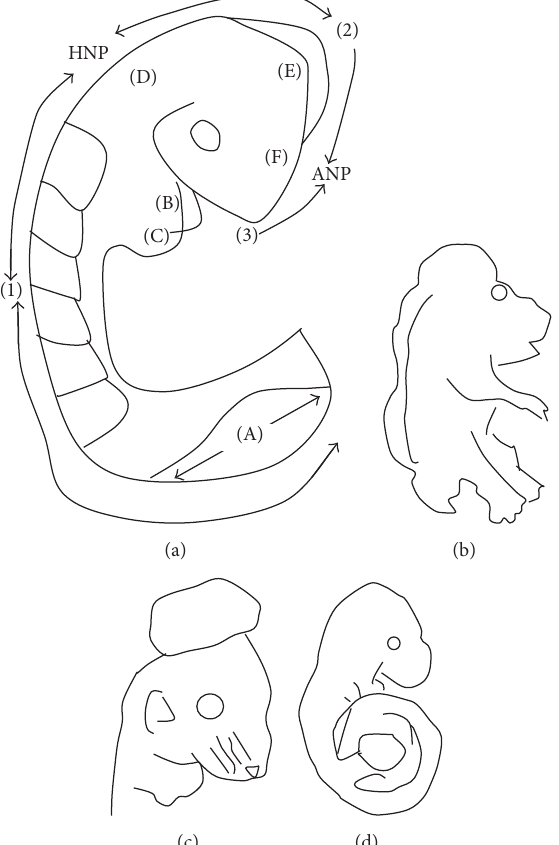
Figure 2: Points of closure in the mouse embryo and phenotypes of failure of closure of the various points along the neuraxis. (a) Schematic figure illustrating the multiple points of closure of the neural tube, directions of closure, and the different locations of neuropores in the developing embryo. (1), site of closure (1) which occurs at the level of somite 3 in the 6-7-somite embryo. Closure (1) is the initiation event of neurulation. Closure then progresses caudally and is completed by closure of the posterior neuropore (PNP) at the 29-30-somite stage of development; (2), second closure site at around the 10-somite stage; (3), closure (3) site which begins soon after closure (2). Arrows depict spreading of neural tube closure to neighbouring regions with completion of anterior neuropore closure soon after initiation of closure (3) and closure of the hindbrain neuropore at the 18–20-somite stage. (b) Phenotype resulting from failure of closure (1): craniorachischisis; (c) phenotype resulting from failure of closure (2): exencephaly; (d) phenotype of failure of the caudal wave of spinal closure, leading to an enlarged PNP and later development of spina bifida. (A), posterior neuropore; (B), branchial arches; (C), developing heart; (D), hindbrain; (E), midbrain; (F), forebrain; ANP: anterior neuropore; HNP: hindbrain